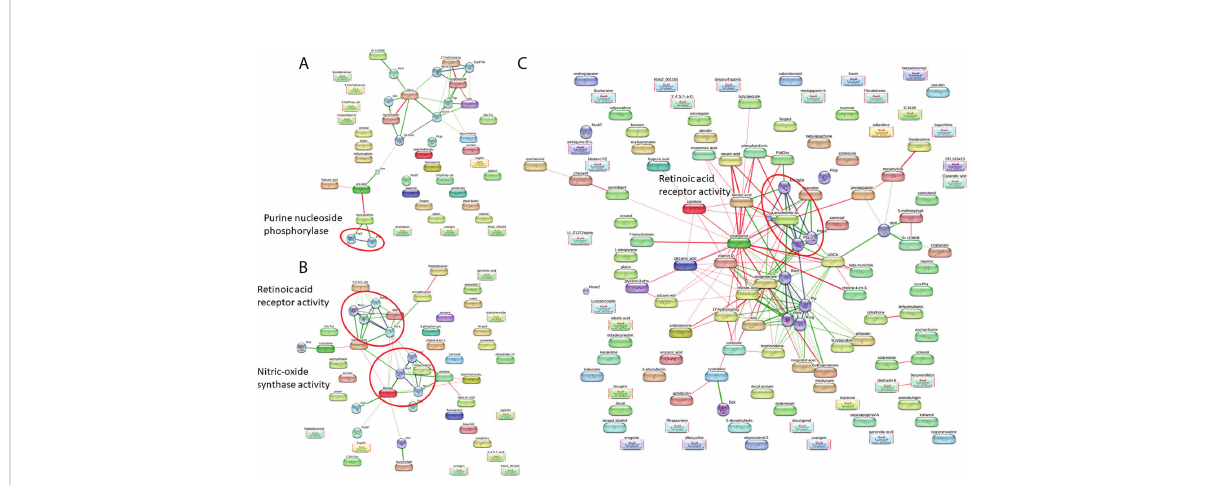
FIGURE 3 Pathway analysis of signi fi cantly altered metabolites at 2 weeks (A) , 4 weeks (B) , and 8 weeks post-infection (C) .